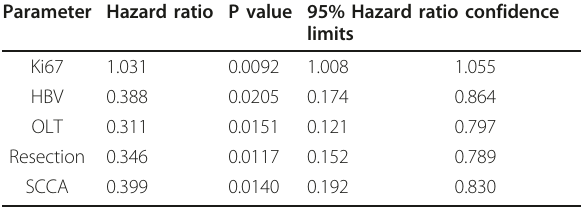
Table 4 Independent variables associated with mortality Parameter Hazard ratio P value 95% Hazard ratio confidence